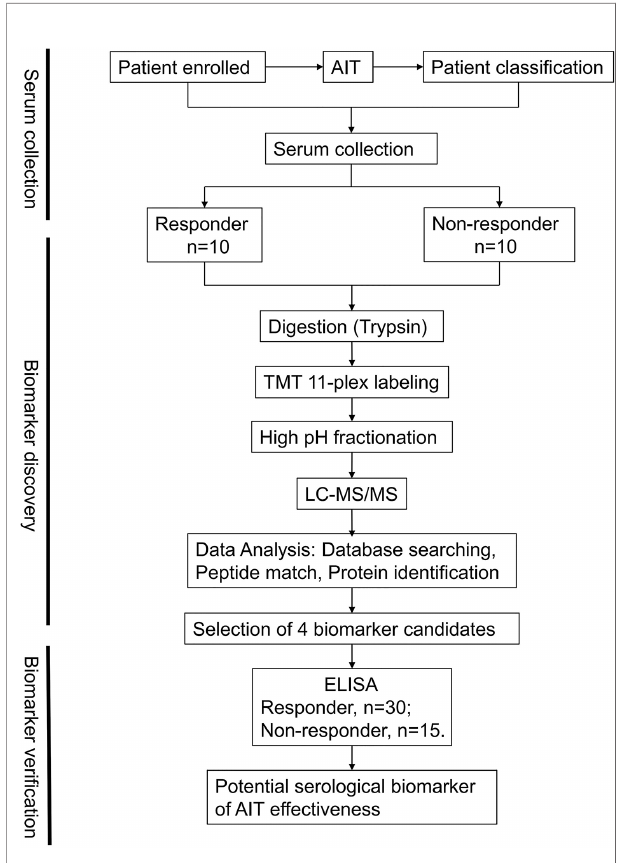
FIGURE 1 | Schematic work fl ow. An overview of the work fl ow used for the identi fi cation of allergen immunotherapy (AIT) ef fi cacy